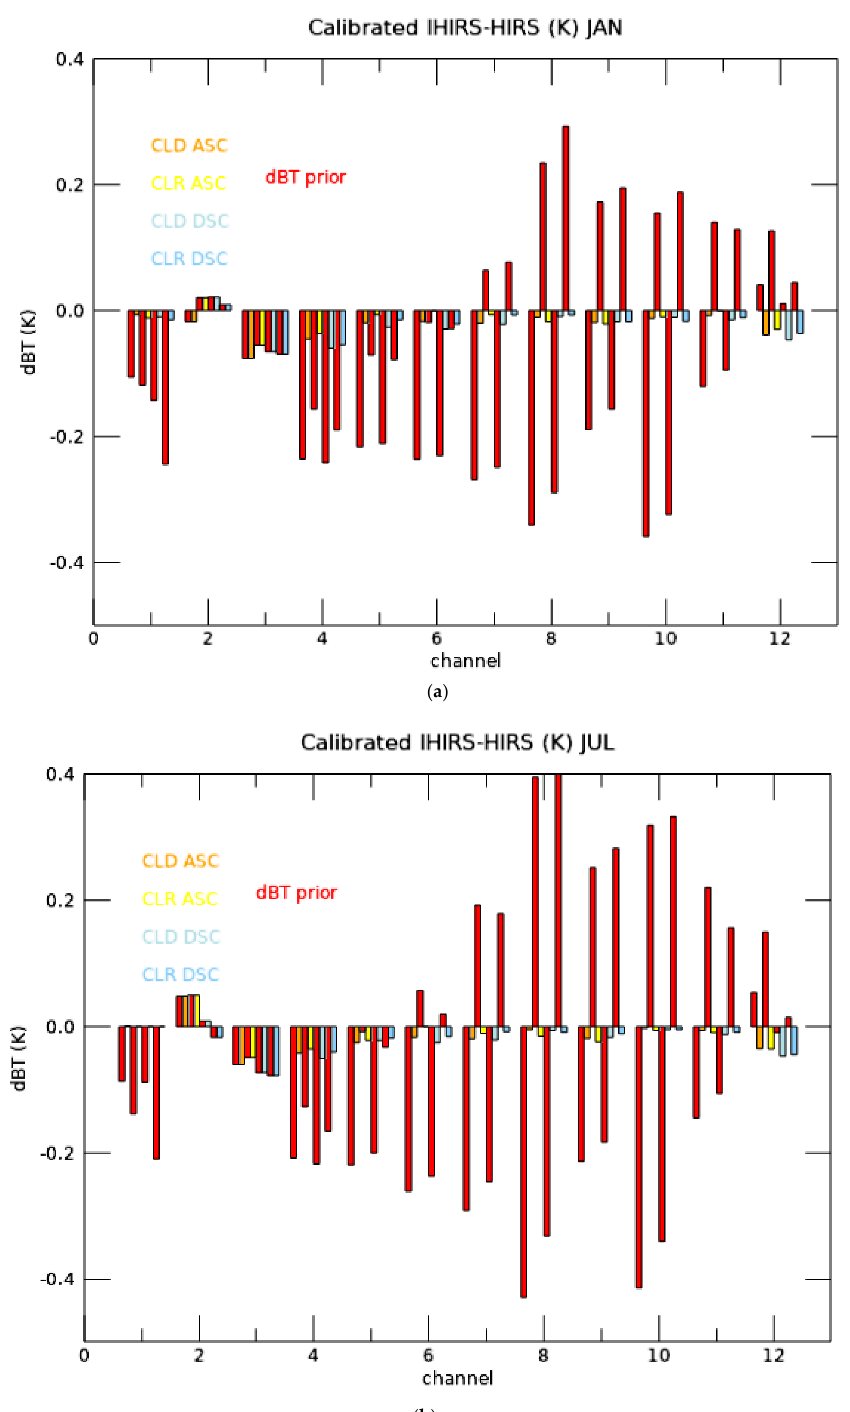
Figure 8. ( a ) The performance of the calibration for all channels (1 – 12) for January. Clusters of eight bars for each channel. Red-colored bars represent dBT prior to calibration, and the other colored bars represent dBT after applying the offsets for each of the four categories (CLD_ASC, CLR_ASC, CLD_DSC, and CLR_DSC). dBT values are the median of 5 years (2011 – 2015). ( b ) Same as Figure 7a, but for the month of July.